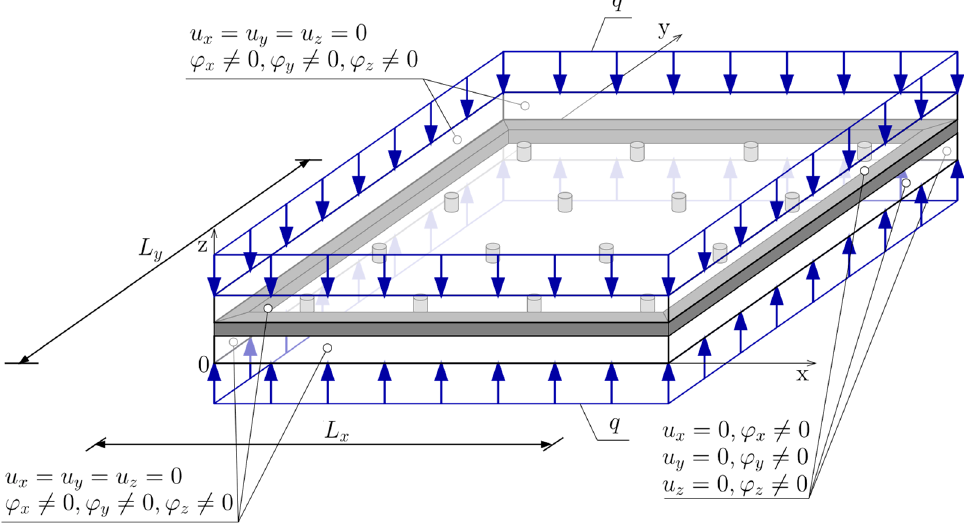
Figure 3. VIG plate computational model—boundary conditions and loads.